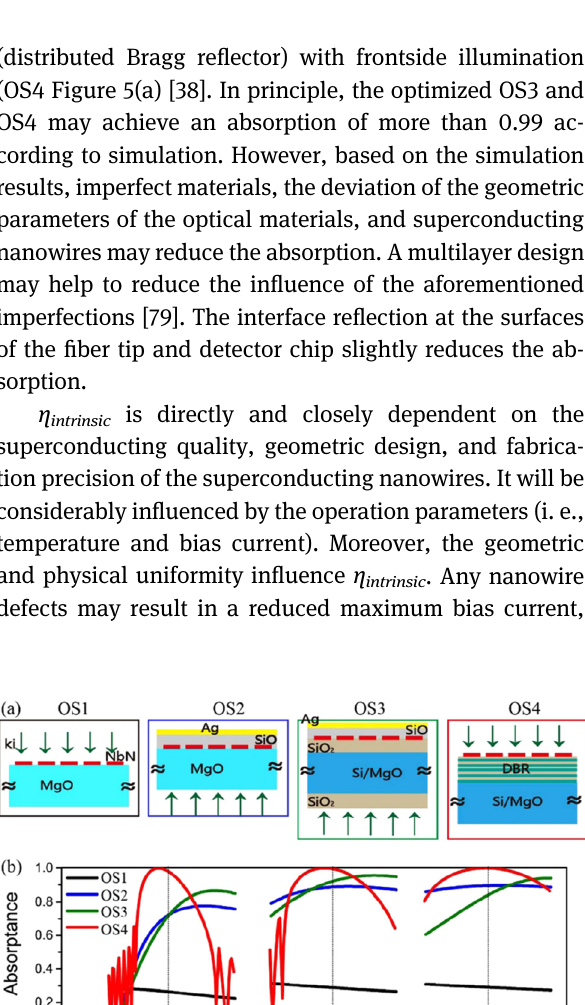
Figure 4: (a) SEM image of a meandered SNSPD with an optical cavity on the top. The left-top inset that shows the nanowire has a line width of 100 nm, and the right inset shows an optical image of a packaged SNSPD with fiber-alignment; (b) oscilloscope single shot of a single- photon response signal.